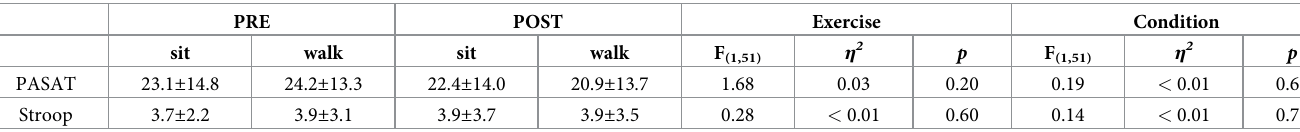
Table 1. Descriptive statistics for the number of errors in the two cognitive tests. PRE POST